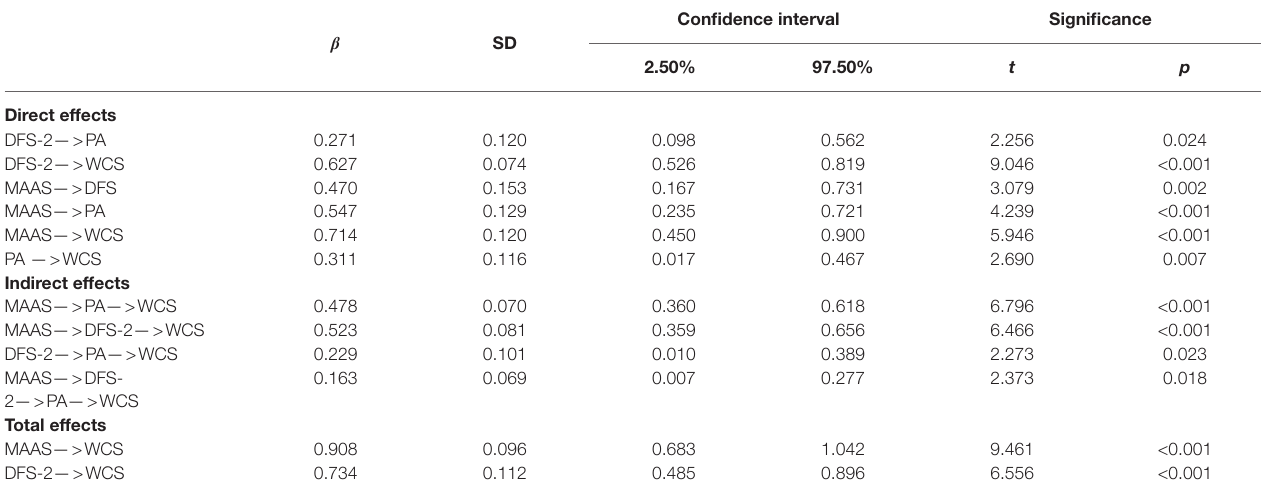
TABLE 7 | Path coefficients of research framework. Confidence interval β SD